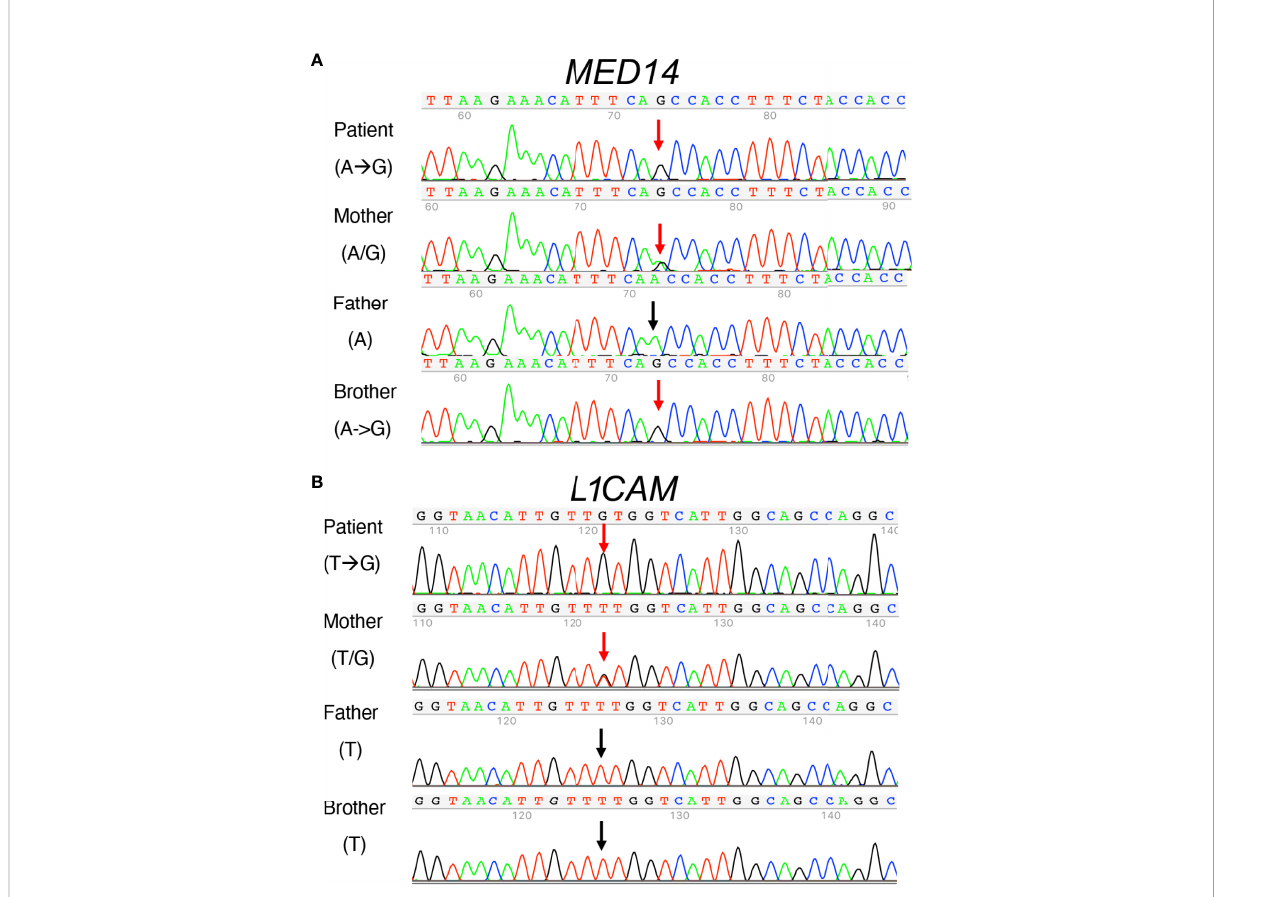
FIGURE 5 Sanger sequence analysis of MED14 V763A and L1CAM Q498H variants in the patient, his parents, and his healthy brother. (A) The mother carries both alleles with A and G The patient and his healthy brother inherited the same alleles with G, resulting in the same MED14 V763A variant as indicated by red arrows. The PCR-Rev primer was used for sequencing. (B) Patient ’ s mother carries T and G alleles (red arrow). The patient inherited the allele with G (red arrow), resulting in the L1CAM Q498H variant and his healthy brother inherited the allele with T (see black arrow). His father ’ s allele also has a T (black arrow). PCR-Fwd primer was used for